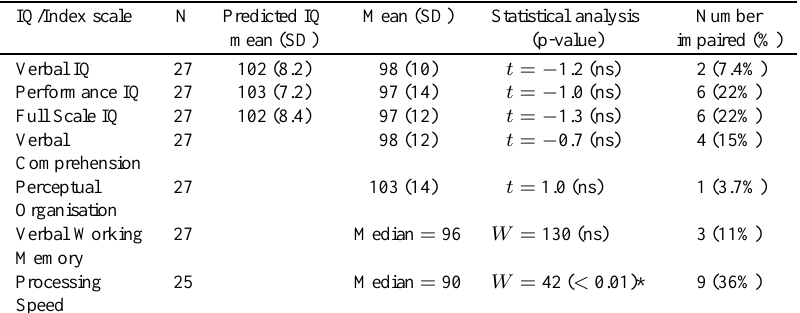
Table 1 Pre-morbid and current intellectual functioning of SCA-6 group and comparison with control